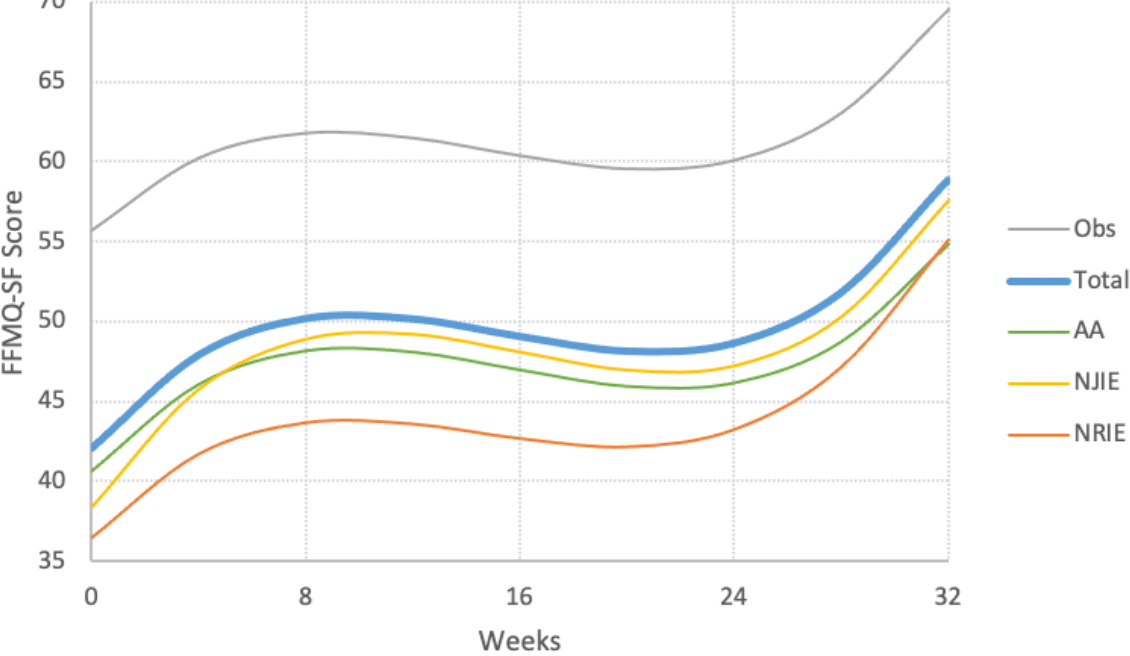
Figure 1. Association between time since installation and being observant (Obs), acting with awareness (AA), nonjudging of inner experience (NJIE), and nonreactivity to inner experience (NRIE). FFMQ-SF: Five-Facet Mindfulness Questionnaire-Short Form.